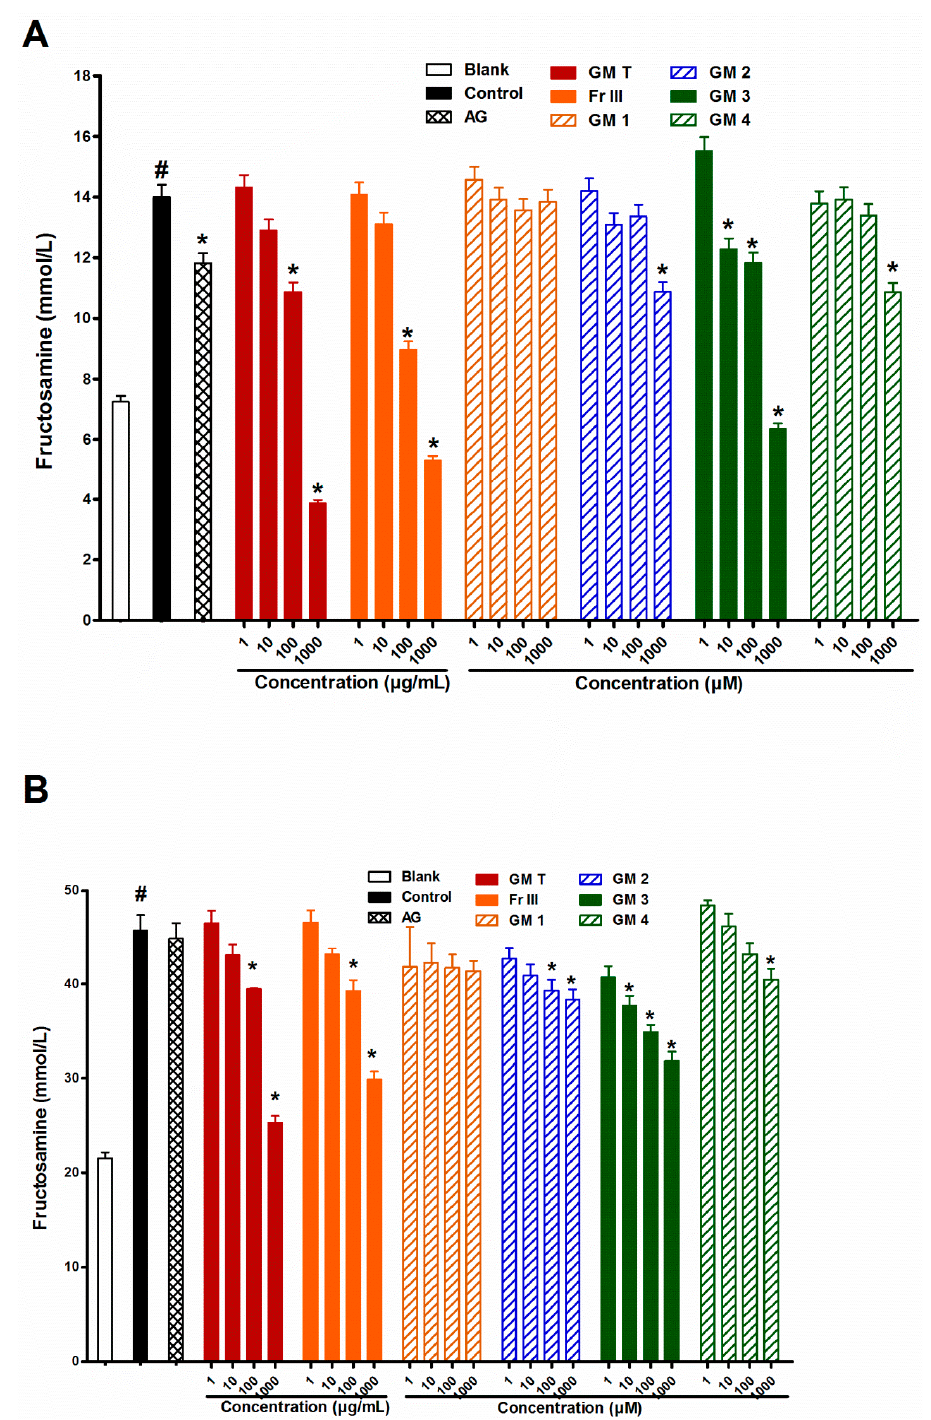
Figure 4. Effect of GMT, Fr III and isolated compounds on fructosamine (An amadori product) level when BSA incubated with glucose ( A ), and ribose ( B ) at week 4. Blank is a reaction mixture including BSA and glucose or ribose kept at − 20 °C while control is the same reaction mixture but incubated at 37 °C. AG was used as standard anti AGEs drug. Results are expressed as mean ± SEM ( n = 3). # p < 0.05 when compared to Blank, * p < 0.05 when compared to Control.